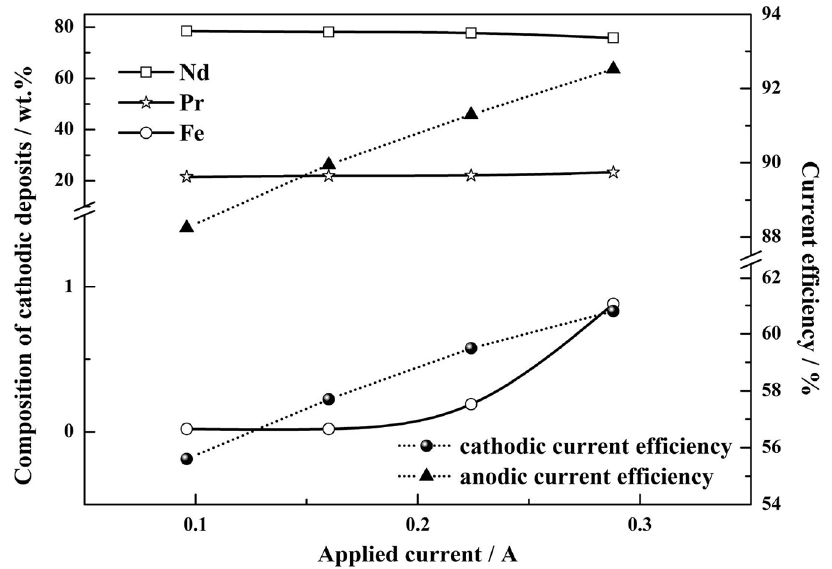
Figure 13. The composition of cathodic deposits and current efficiency as a function of applied currents. Reproduced with permission [105]. Copyright 2020, Elsevier. Table 3. Summary of metal recovery from e-waste using electrochemical approaches, electrodeposition, and elec- trowinning.